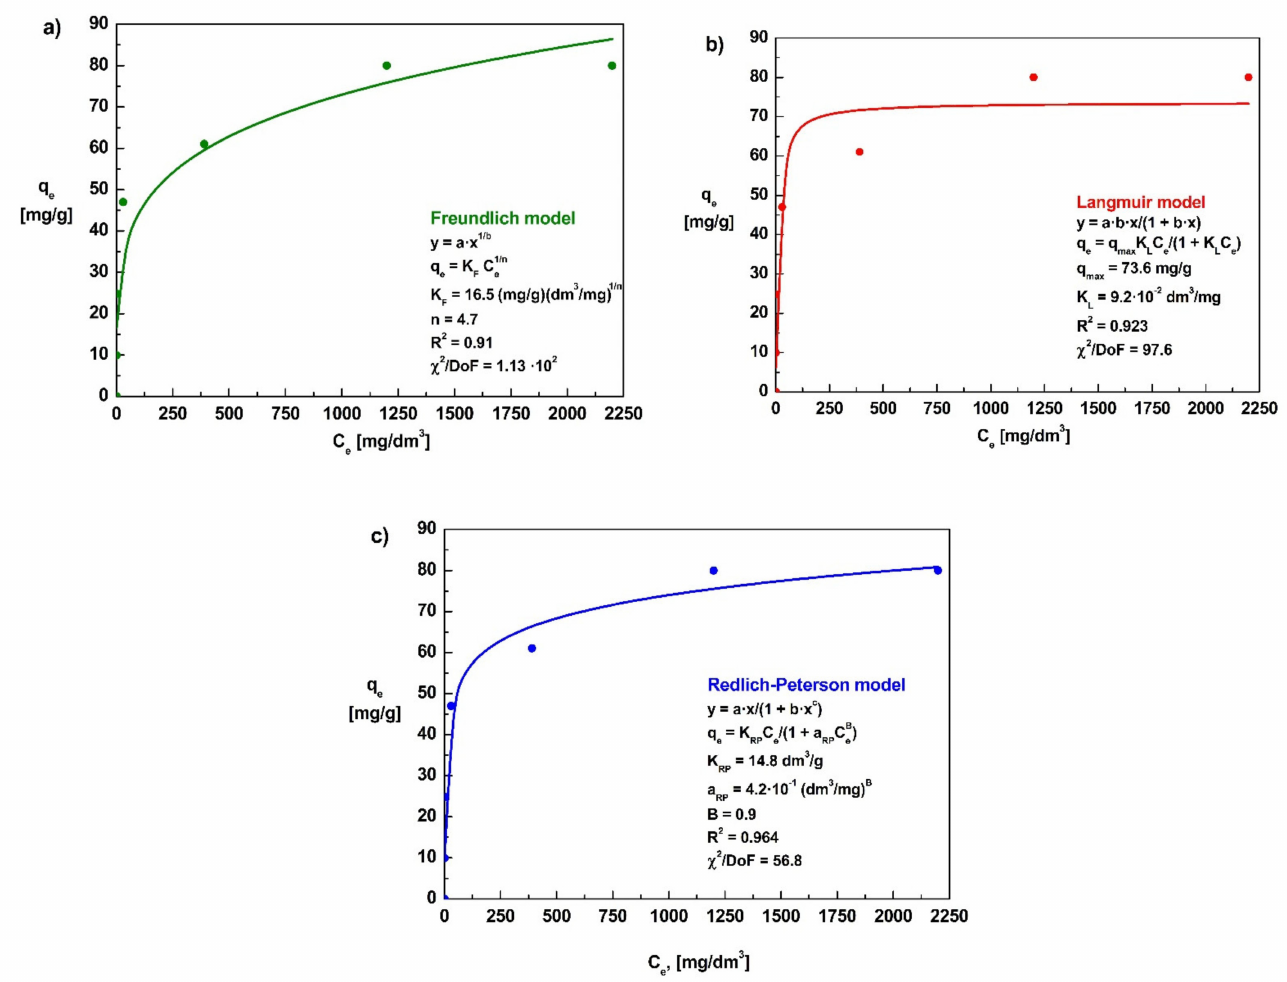
Figure 2. Freundlich ( a ), Langmuir ( b ), and Redlich–Peterson ( c ) isotherm of Cu(II) adsorption on Table 2 composite. The obtained dye-removal effects were promising compared to the abilities of CFA and HAp. Using 1 g of HAp, the adsorption capacities for various dyes was characterized, including 29.5 mg of methylene blue [16], 49.1 mg of brilliant green [81], 85.51 mg of carmine [30], and 125 mg of reactive yellow [31]. This comparison is, naturally, an approx- imation due to the various properties of the dyes and different experimental conditions of the pH-dependent process. The adsorption capacity of RB onto CFA was 4.25 mg/g at pH 1 and decreased along with the pH: the adsorption capacity was 2.4 mg/g at pH 12 and was about 2.75 mg/g at pH 11 [82]. These capacities were much lower than those obtained for the CFA–HAp composites. The closest comparison can be made with the mineral and organic materials presented in Table 6. Given these results, the adsorption capacities of the CFA–HAp composites appear